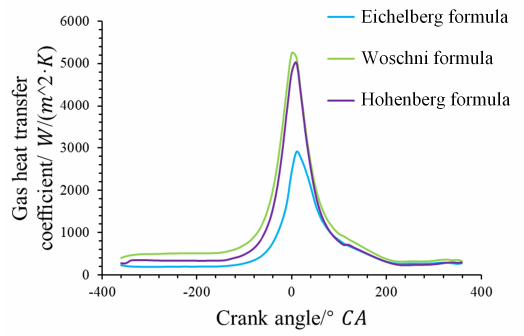
Fig. 2. Comparison of instantaneous heat transfer coefficient calculated by three